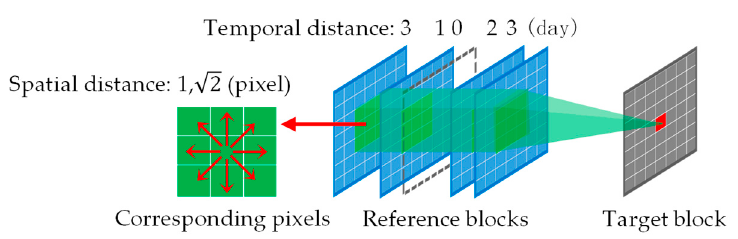
Figure 4. Example of spatio–temporal weighted averaging.